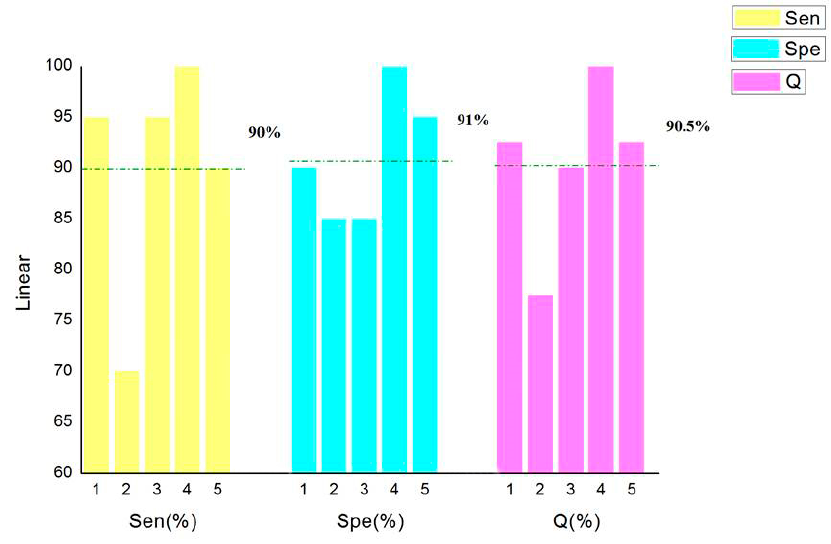
Figure 3. Cross-validation results of linear kernel function.